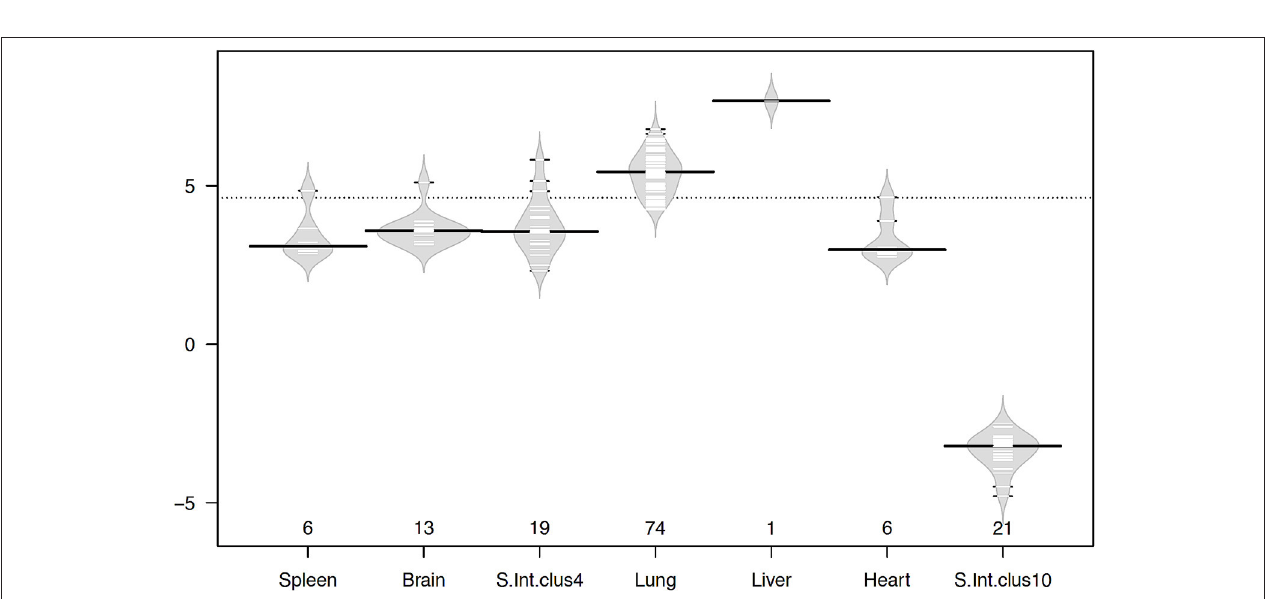
FIGURE 5 | the liver, averaging 1 gene per cluster. The DEGs clustered into 7 major groups, demonstrated in (A) heat map and (B) graphical format, based on patterns of gene expression across the differing cat tissues. Red and green circles indicate the tissue-specific up- and down regulated genes, respectively. Negative values indicate decreased expression, and positive values indicate increased expression. (C) GO analysis of DEGs within clusters after FPKM filtering identified the top associated enriched GO terms with corresponding enrichment P- values, shown on right.